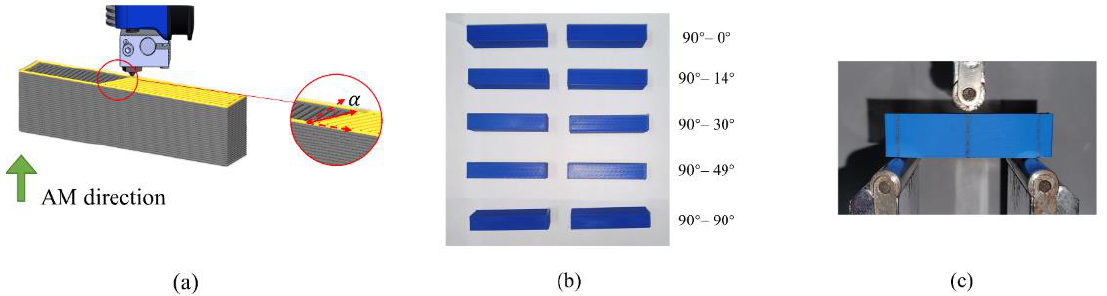
Figure 7. Mechanical test details: ( a ) the sample printing setup, ( b ) the fabricated experiment specimens, and ( c ) the test setup.